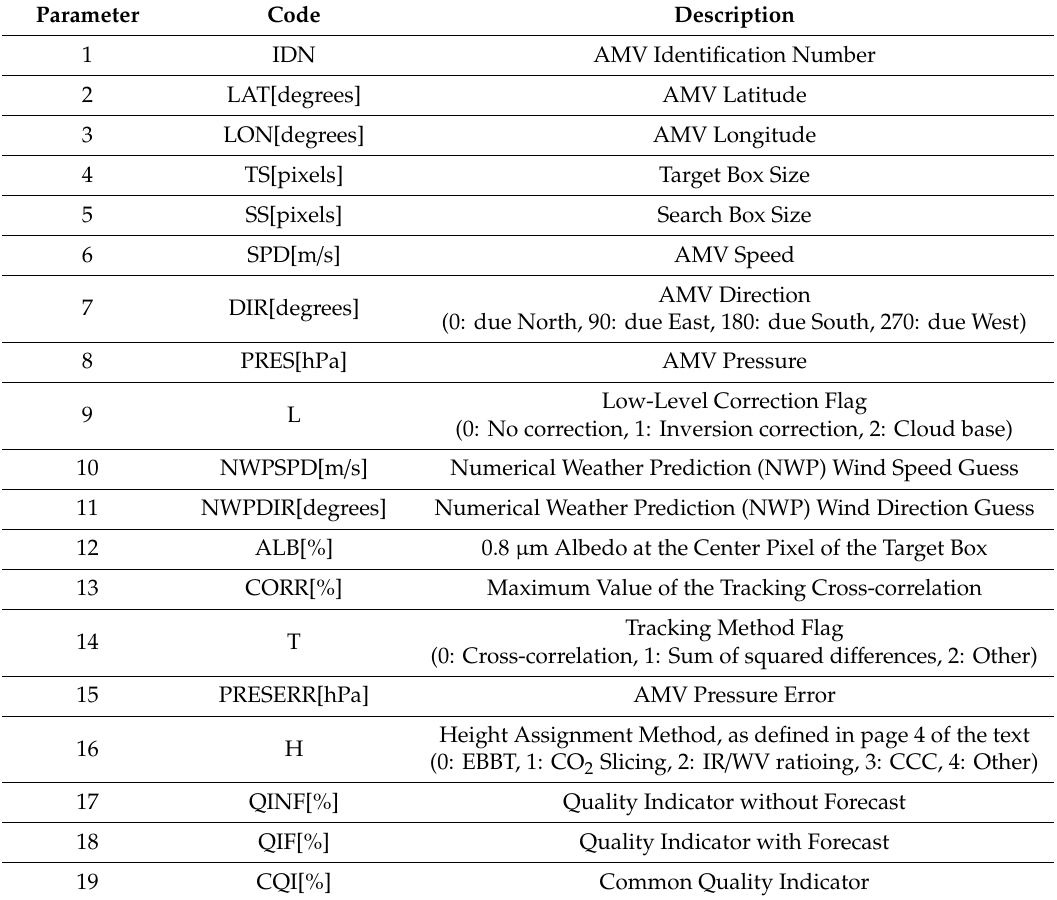
Table 1. Reported variables for the AMVs (Atmospheric Motion Vectors) in all